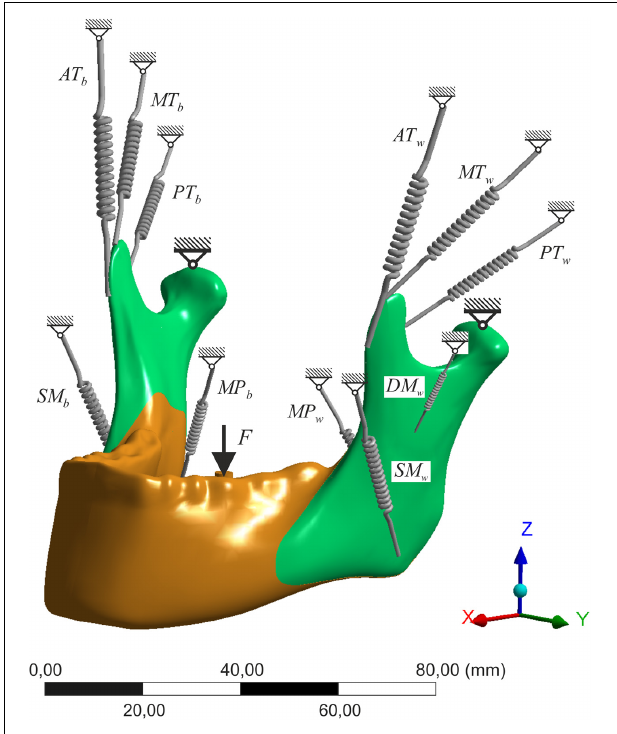
FIGURE 2 | The scheme of the numerical model; SM, superficial masseter; DM, deep masseter; MP, medial pterygoid; AT, anterior temporalis; MT, medial temporalis; PT, posterior temporalis; w, working side; b, balancing